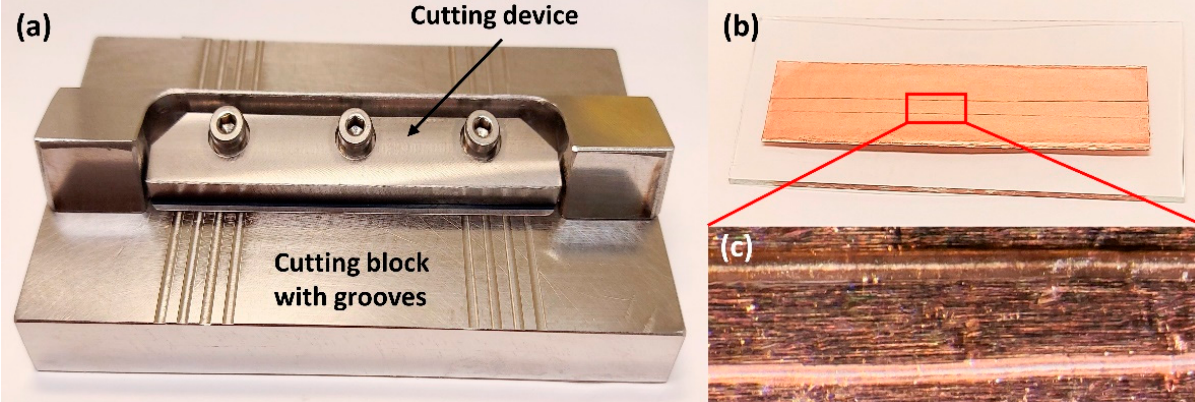
Figure 6. Images show the preparation of longitudinal sections of single hair samples. ( a ) The device with 20–80 µ m grooves used for longitudinal sectioning of hair samples; ( b ) Longitudinal hair sections are attached into double-sided copper tape; ( c ) Optical images of the longitudinal sections of single hairs. This device was designed based on references [76,106]. Photos by the